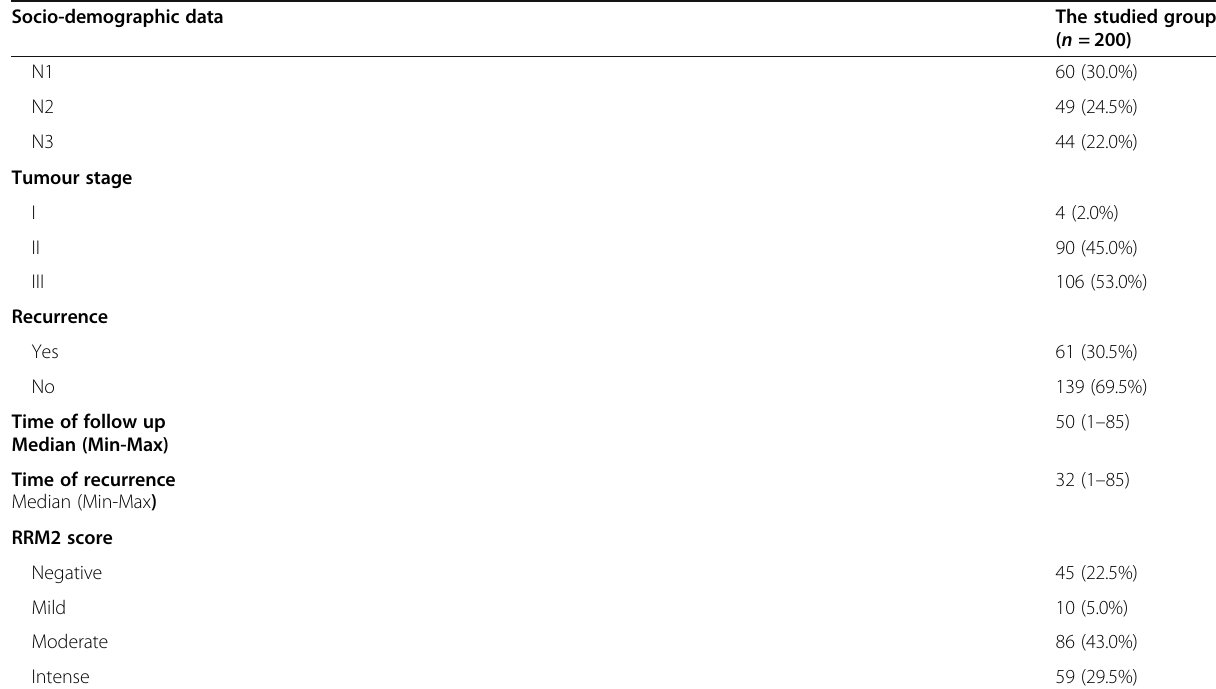
Table 1 Clinical and pathological characteristics of patient cohort (Continued) Socio-demographic